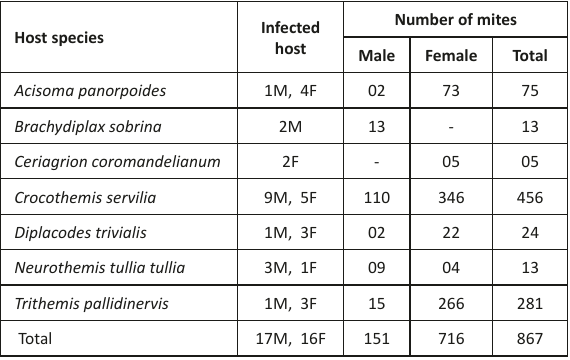
Table 2. Prevalence of Arrenurus aquatic mite infestation on odonates at Wena Dam.